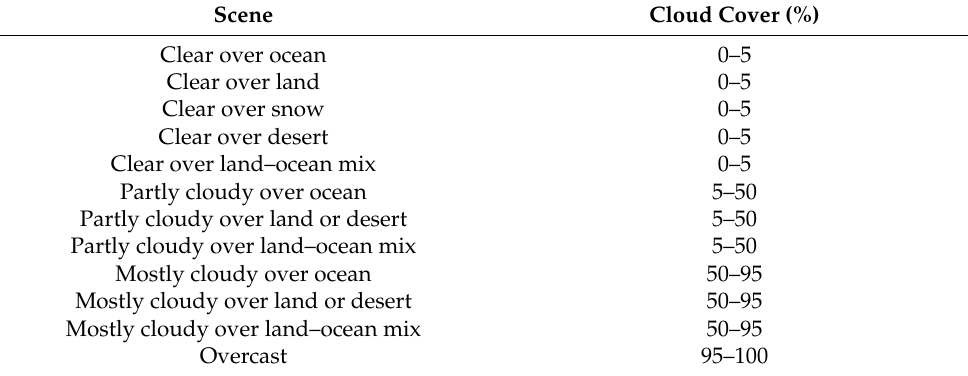
Table 1. Scene Types for ERBE SW ADM.